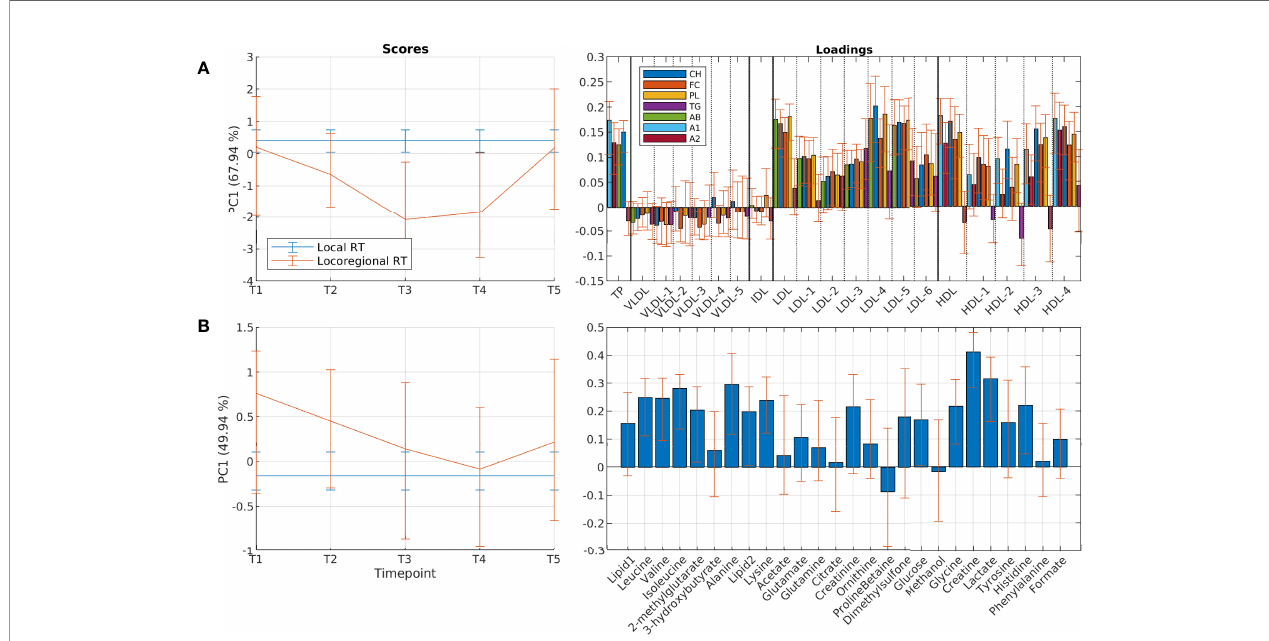
FIGURE 4 | Differences in circulating lipoprotein subfractions and metabolites between patients receiving local and locoregional radiation. Results show scores and loadings from RM-ASCA+ analysis including treatment and time-treatment interactions for (A) lipoprotein subfractions and (B) circulating metabolites. Treatment is reference coded to local radiation, which therefore is shown as a fl at line in the score plot. The scores (left) show the overall development for different treatment groups over time (T1-T5), and must be interpreted together with the corresponding loadings (right). Higher score value means that the group has higher levels of variables with positive loadings and lower levels of variables with negative loadings compared to the group with lower score values. Distinct changes appear in lipoprotein pro fi les of patients receiving locoregional radiation after 3 and 6 months, however returning to a similar pro fi le as patients that received local radiation after 12 months. A1, apolipoprotein-A1; A2, apolipoprotein-A2; AB, apolipoprotein-B; CH, esteri fi ed cholesterol; FC, free cholesterol; PC, principal component; PL, phospholipids; RT, radiotherapy; TG,